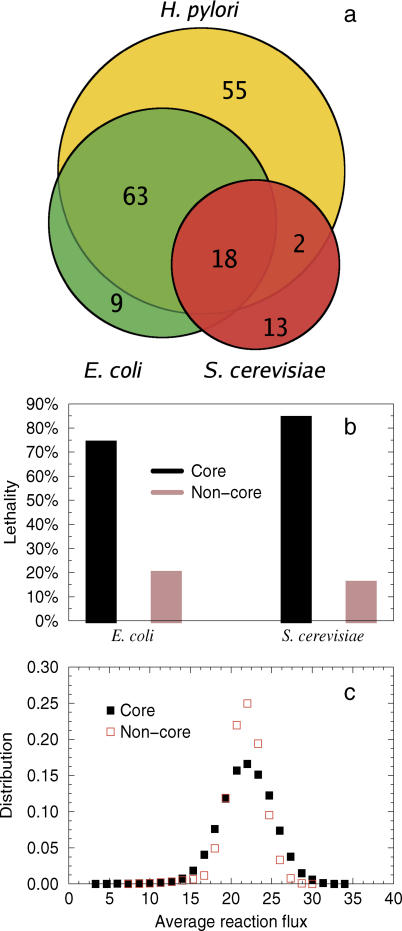
Characterizing the Metabolic Cores(A) The number of overlapping metabolic reactions in the metabolic core of H. pylori, E. coli, and S. cerevisiae.
(B) The fraction of metabolic reactions catalyzed by essential enzymes in the cores (black) and outside the core in E. coli and S. cerevisiae.
(C) The distribution of average metabolic fluxes for the core and the noncore reactions in E. coli.